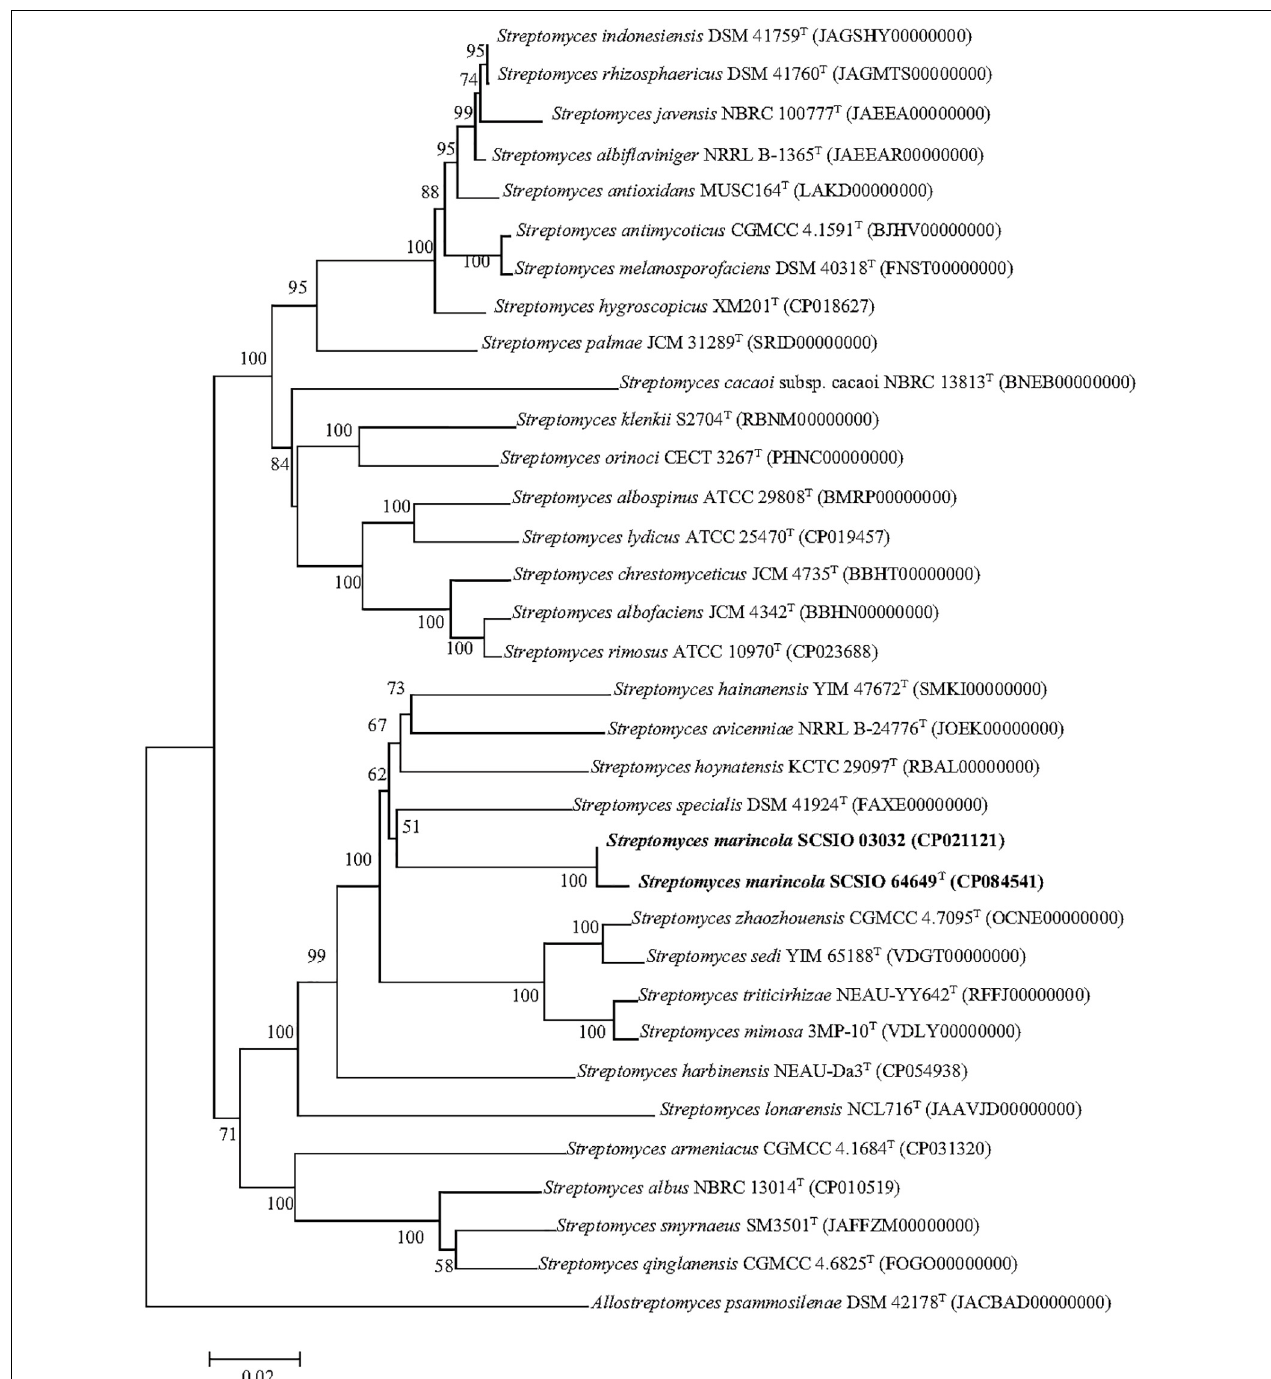
FIGURE 2 | Phylogenetic analysis based on genome sequences of strains SCSIO 64649 T , SCSIO 03032, and related Streptomyces species. The RAxML tree was calculated with the PhyloPhlAn software. Allostreptomyces psammosilenae YIM DR4008 T was added as an outgroup. Bar, 0.02 sequence divergence.